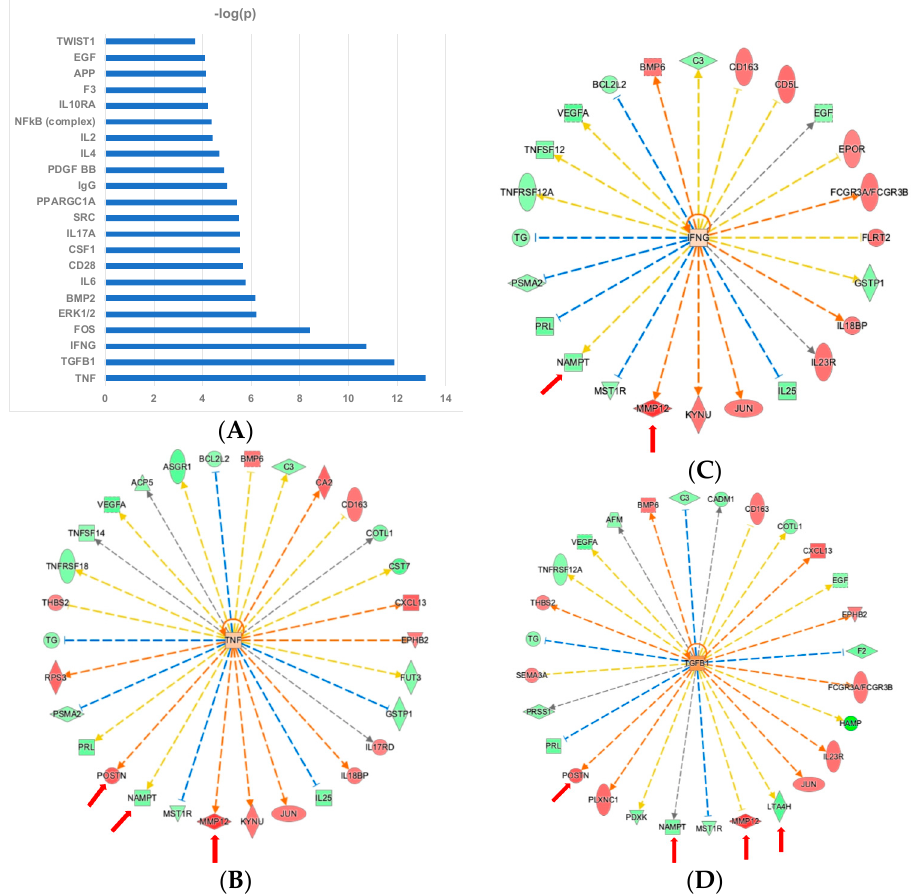
Figure 5. Upstream Regulator Analysis shows significant effects of surgical myectomy on proteins regulated by TNF, IFN γ , and TGF β 1. Upstream regulators that best explain the observed expression changes in the 79 protein list input as their targets ( A ). Analysis of upstream regulators ranked by − log p value ( B ). Downstream targets of TNF ( C ). Downstream targets of IFN γ ( D ). Downstream targets of TGF β 1. Red indicates upregulation and green denotes downregulation in ‘post’. Proteins are coded by shape; square—cytokine, vertical rhombus—enzyme, horizontal rhombus—peptidase, trapezoid—transporter, ellipse—transmembrane receptor, and circle—other. Links are color-coded as red—leads to activation, blue—leads to inhibition, yellow—findings inconsistent with state of downstream protein, and black—effect not predicted. Red arrows indicate proteins of particular interest and relevance.